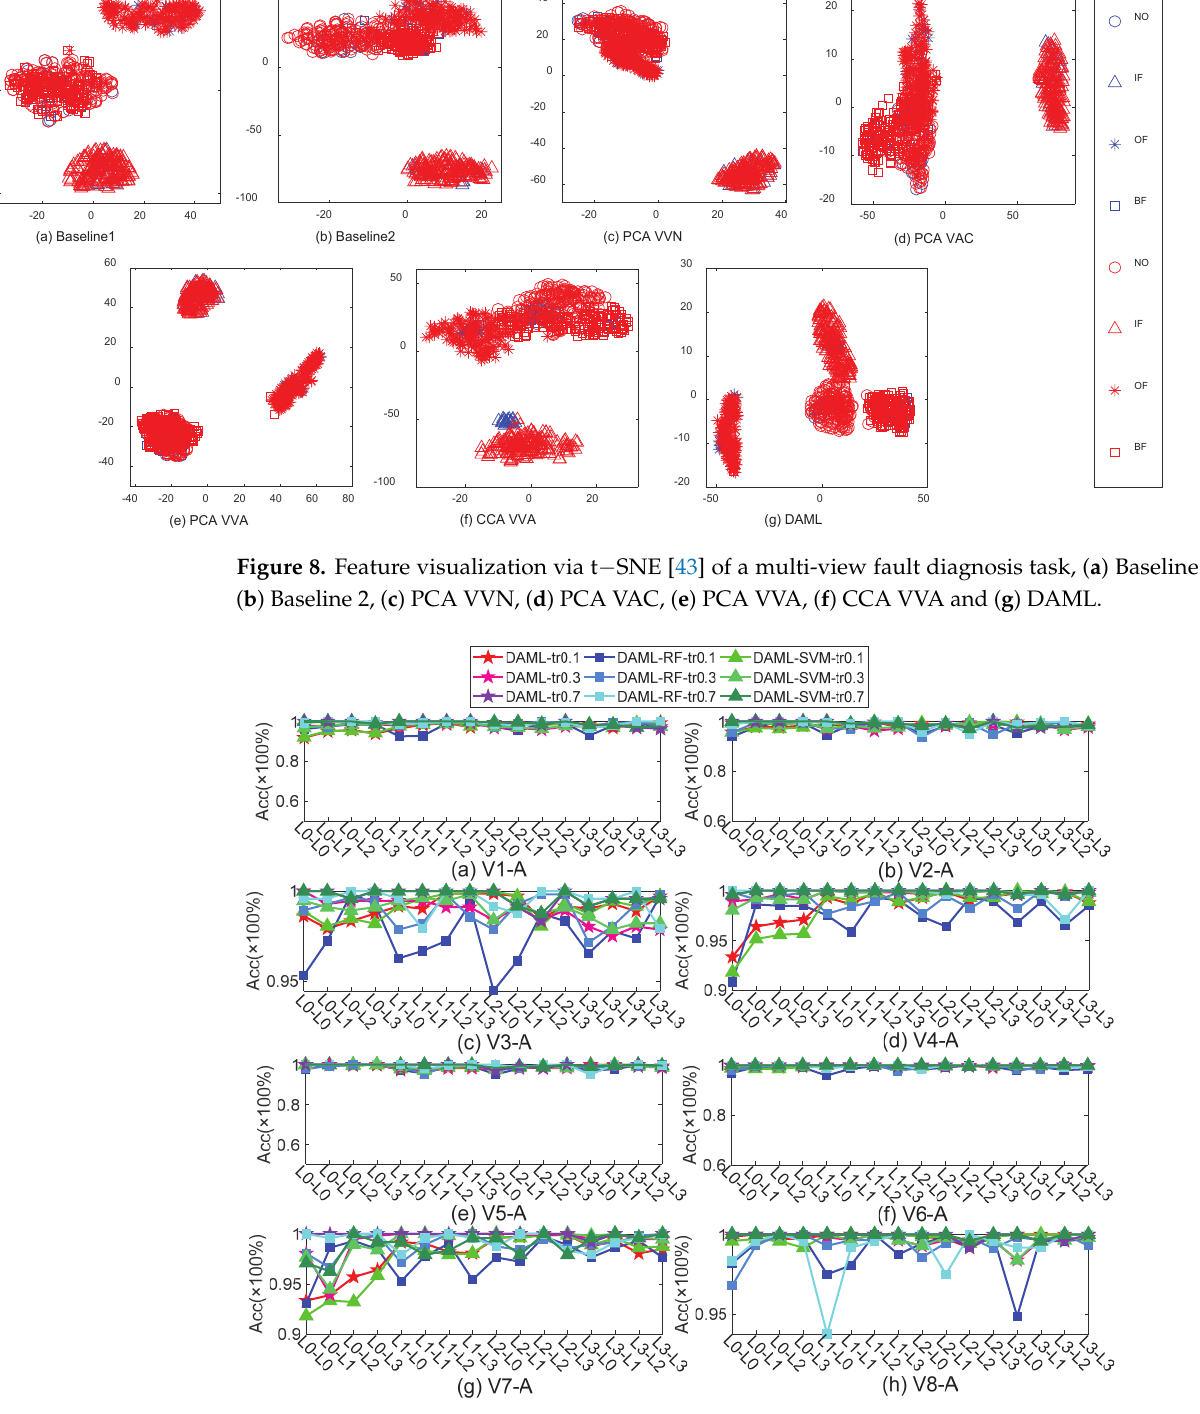
Figure 9. Diagnosis results of DAML with different classification methods, ( a ) V1-A, ( b )